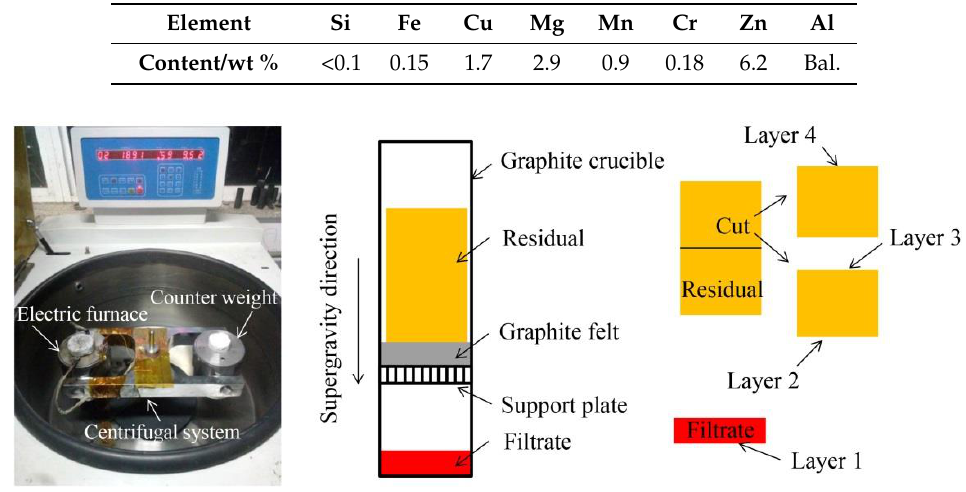
Figure 1. Sketch map of the super-gravity rheorefining apparatus.